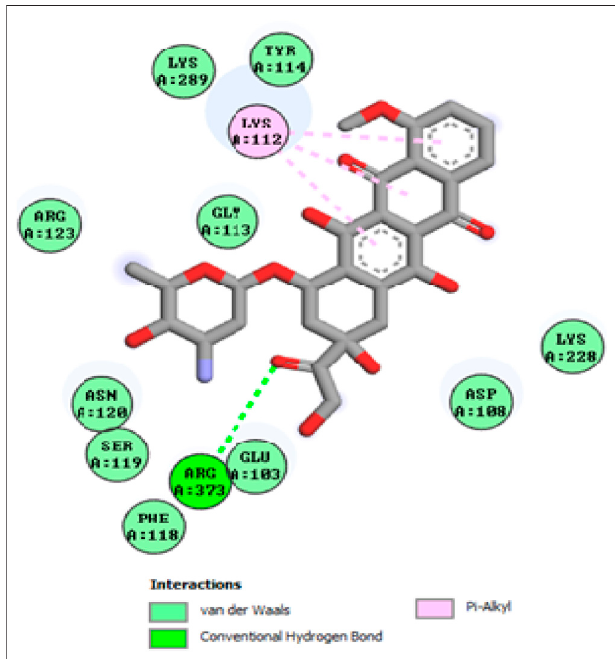
FIGURE15| InteractionofcompoundDoxorubicininthebindingpocket of 1Z11 receptor.